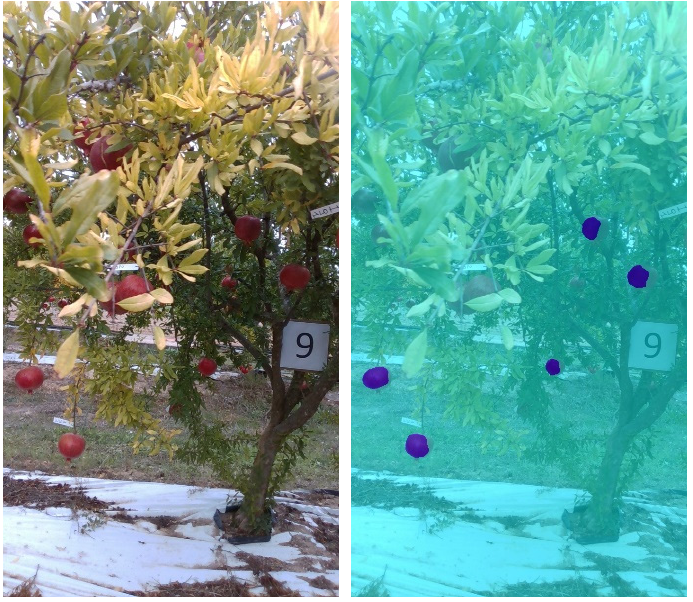
Figure 11. TNA result for the same image as Figure 9. ( Left) : original image; ( right ): segmentation result.